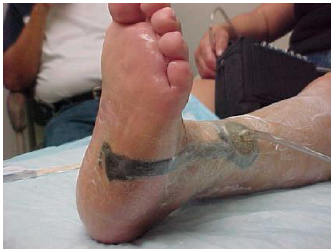
Figure 3. Application of NPWT at week 4.